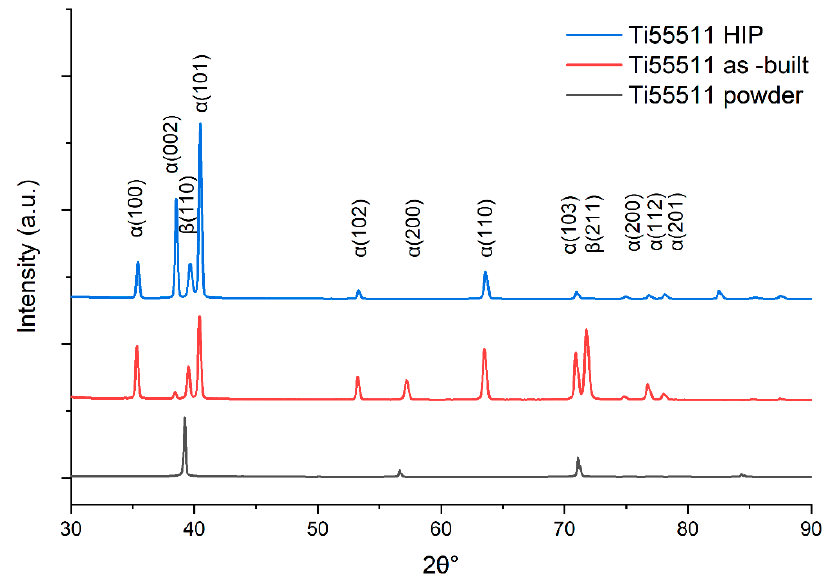
Figure 5. Diffractogram of the Ti-55511 specimens in the as-built and HIP state.